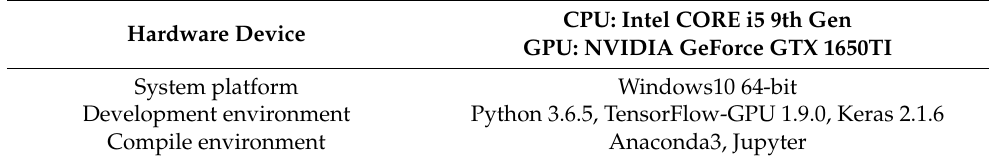
Table 3. Experimental environment configuration.